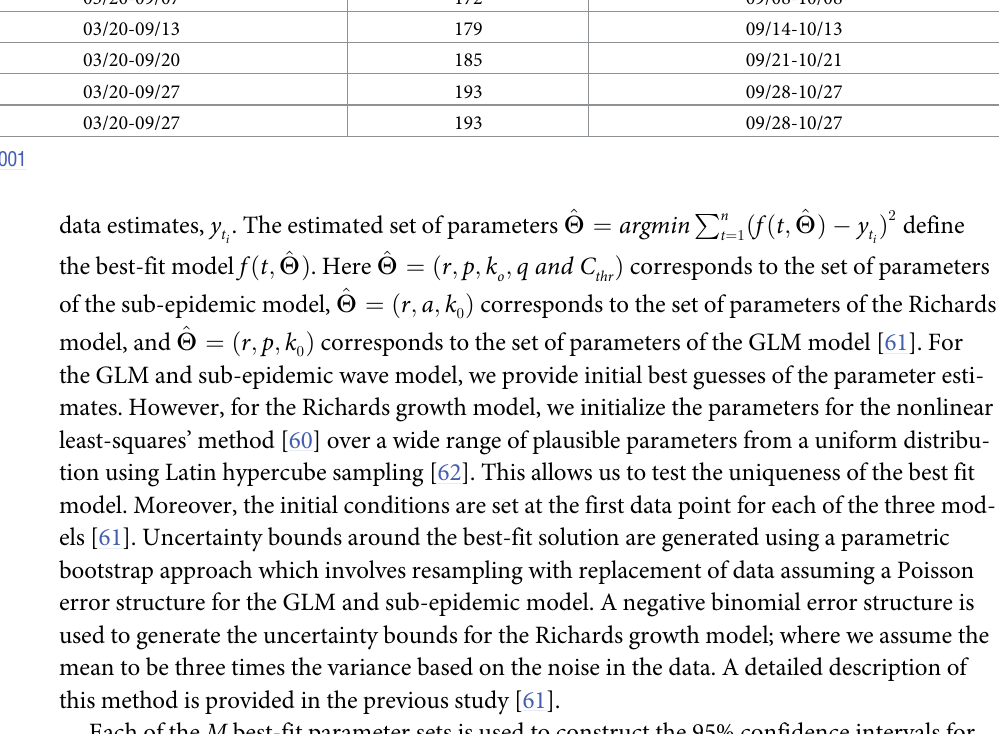
Forecast period for the GLM, sub-epidemic, Richards and IHME